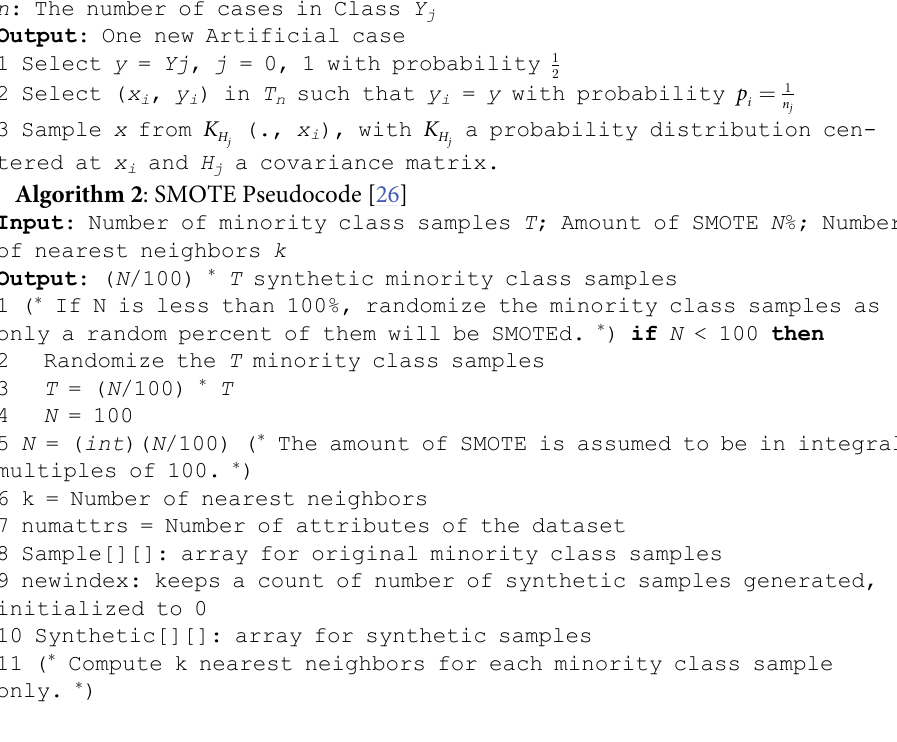
Algorithm 1 : ROSE: Generating one new artificial case [25]